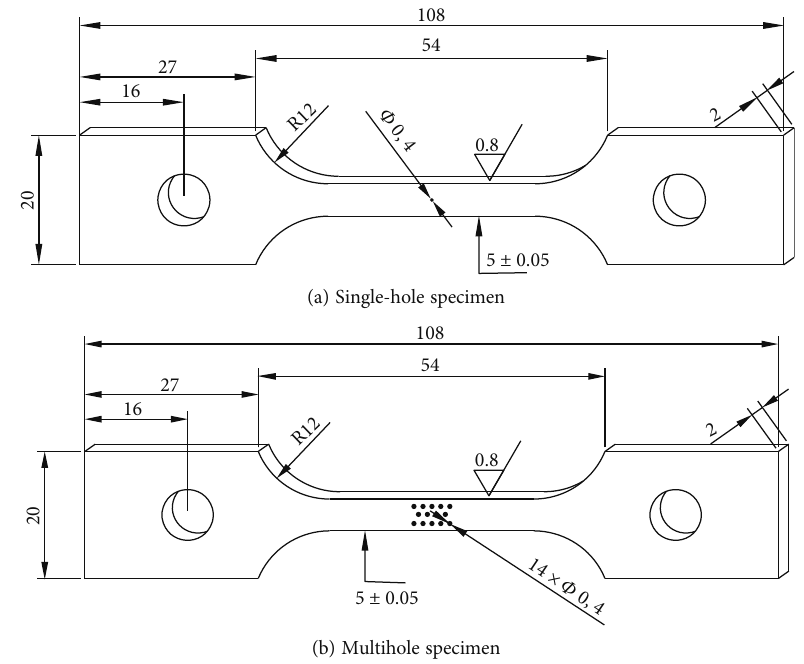
Figure 5: The designed specimens for the